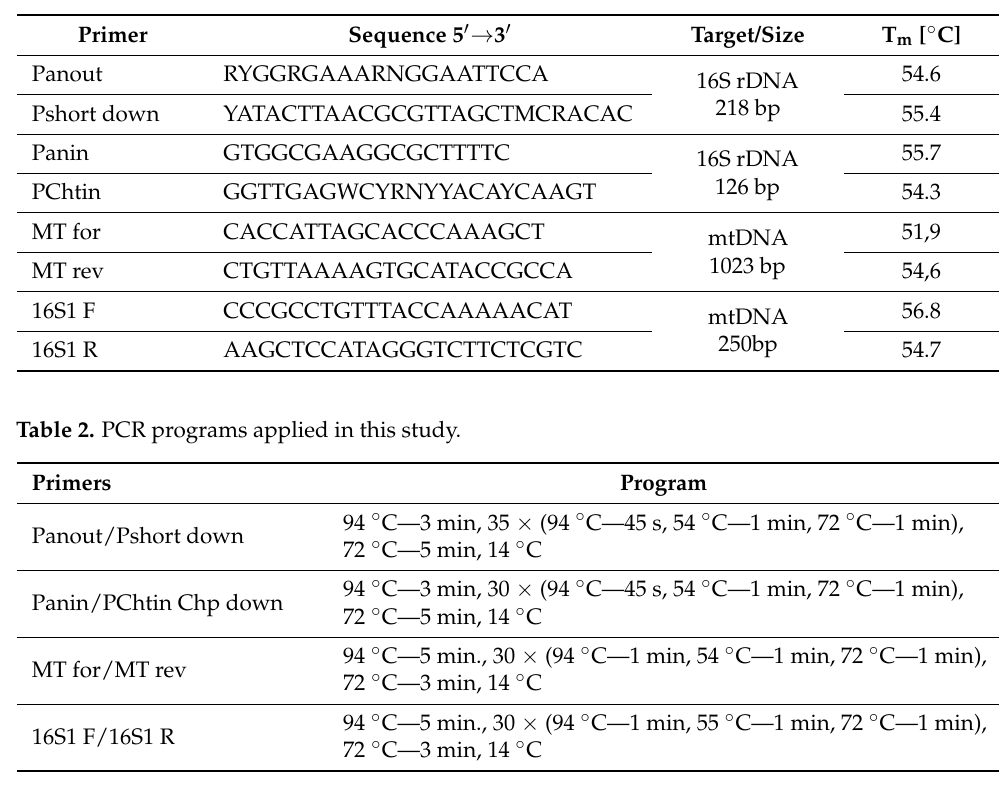
Table 1. PCR primers used in this study.